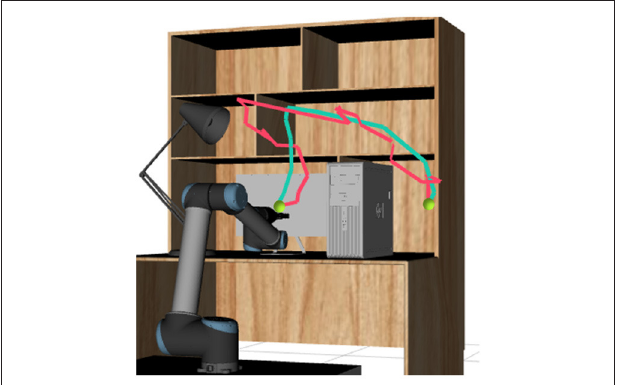
FIGURE 8 | Planning scene of the robot experiment. A 6-DOF UR10 robot is used to conducted the motion task. The red trajectory of the robot end effector is the solution of RRT algorithm. The blue trajectory is the solution optimized by LCQP.